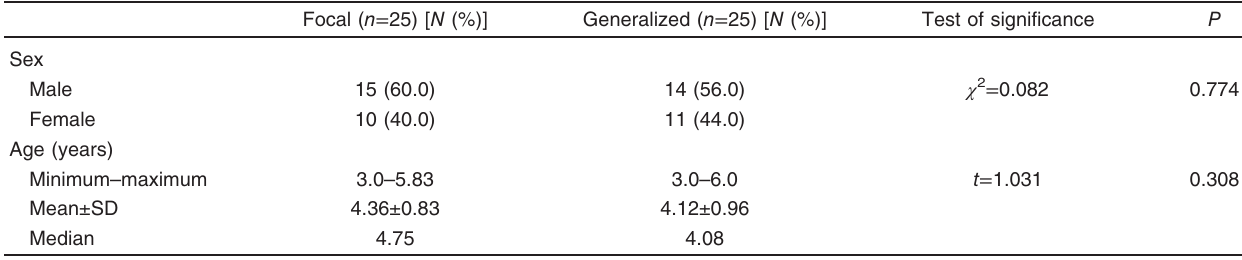
Table 1 Comparison between the studied groups (focal and generalized epilepsy) according to age and sex of the cases